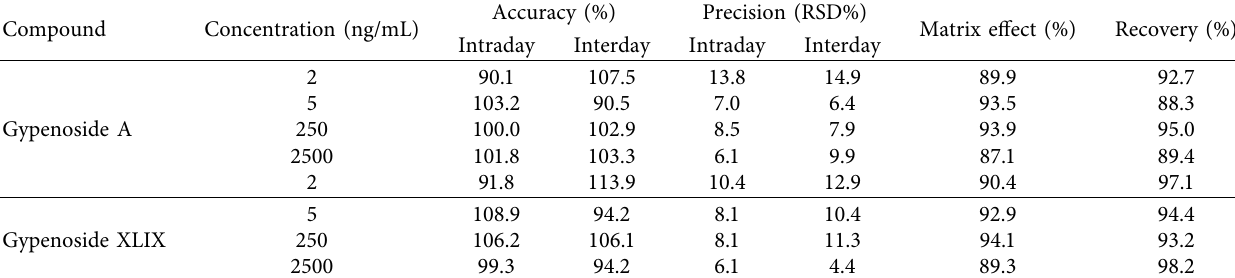
Table 2: Stability of gypenoside A and gypenoside XLIX in rat plasma (%). Compound